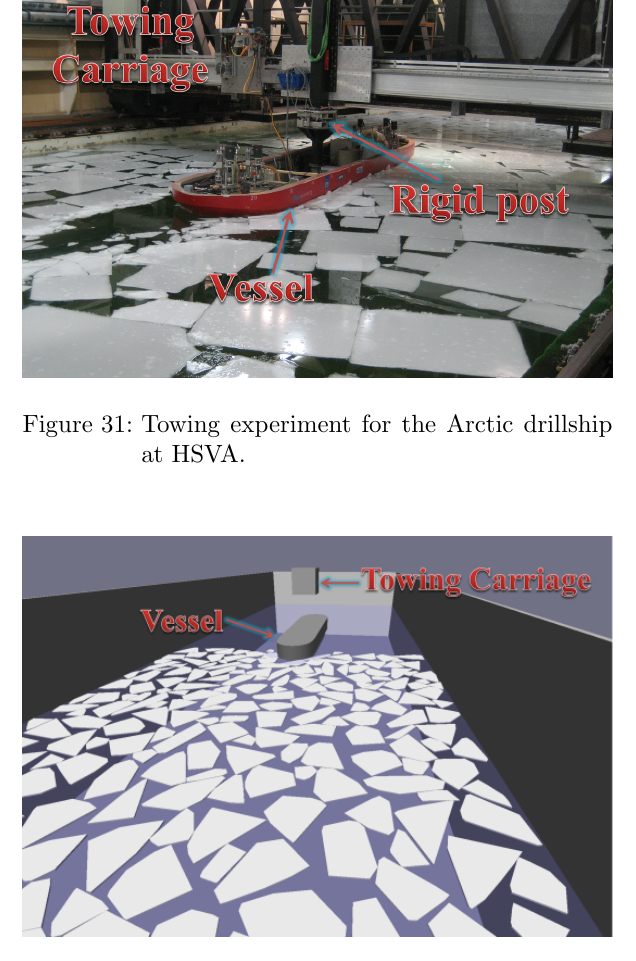
Figure 32: Simulated towing experiment by the numer- ical ice tank model for the Arctic drillship at